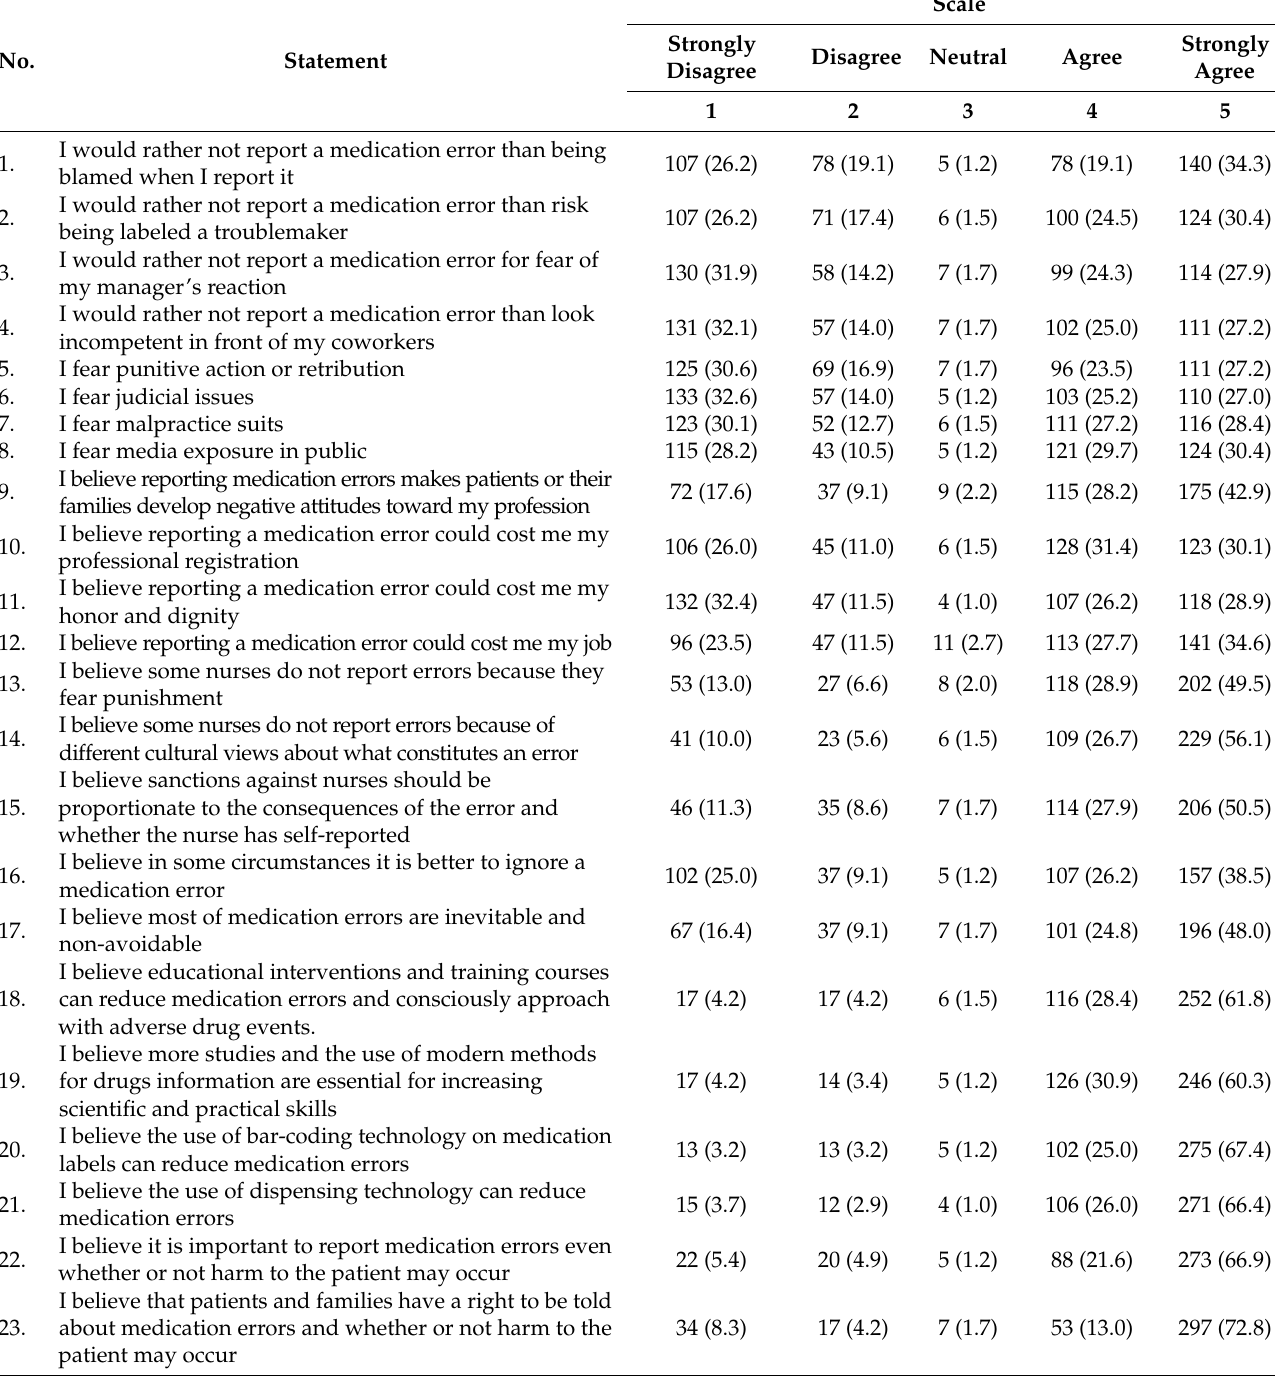
Table 3. Distribution of nurses’ attitudes regarding medication